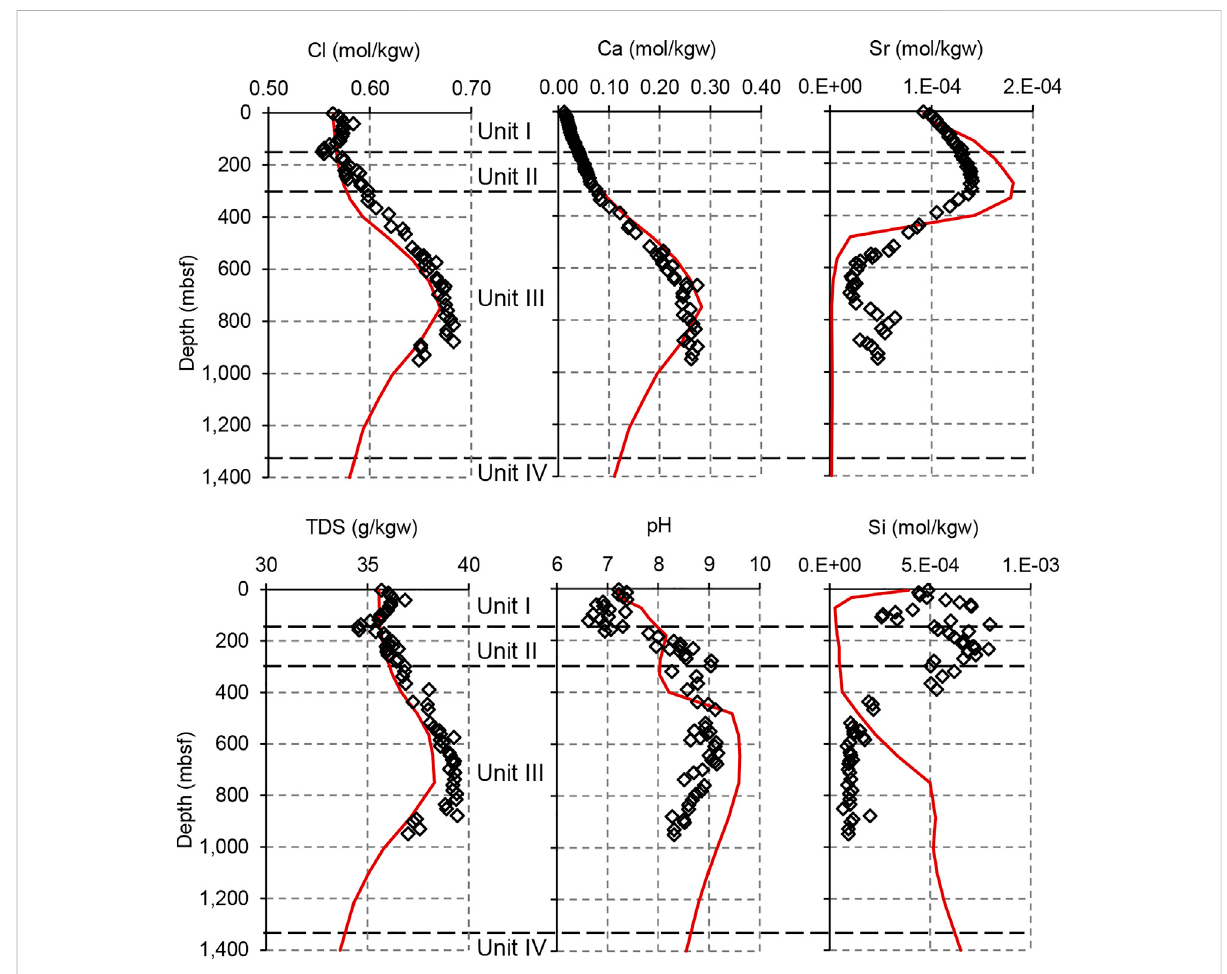
FIGURE 7 Comparison between observed (open diamond) and simulated (red line) porewater depth pro fi les of chloride, calcium, strontium, TDS (Total Dissolved Solids calculated in PHREEQC with observed porewater data), pH and silica. Total depth of the simulation corresponds to that of the sedimentary